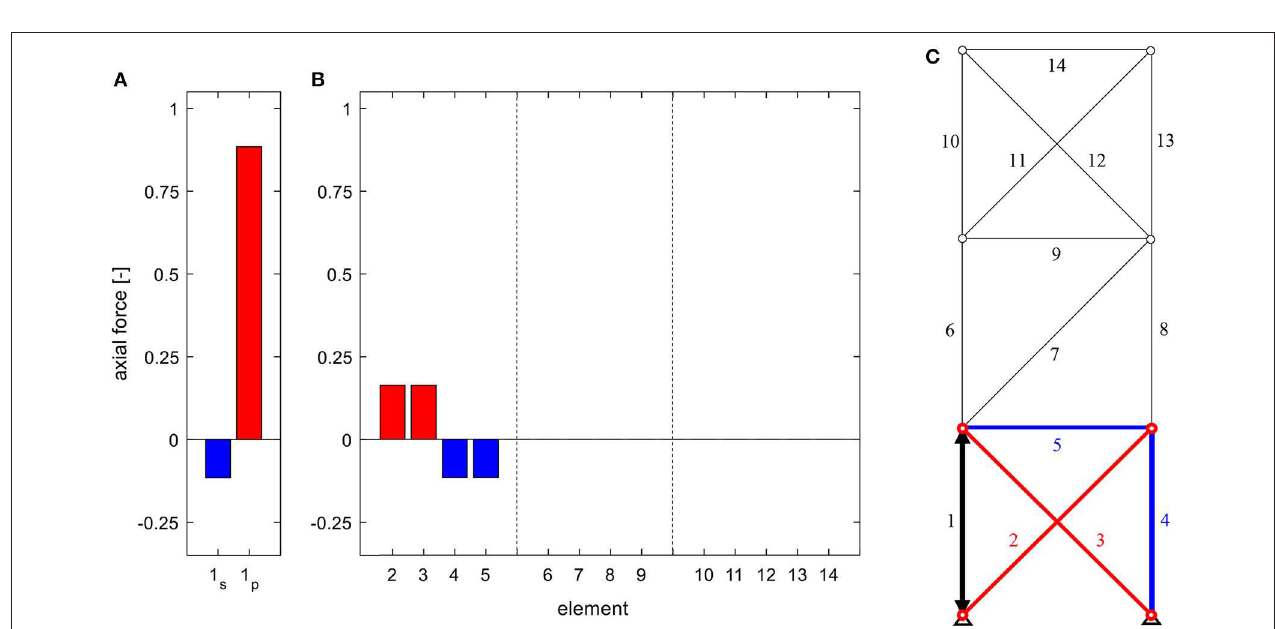
FIGURE 4 | Axial forces in (A) the actuated element for serial (index s ) and parallel (index p) linear actuation, (B) the remaining structure due to the actuation of element 1 (C) , for a truss of the static degree of indeterminacy of n s = 2.